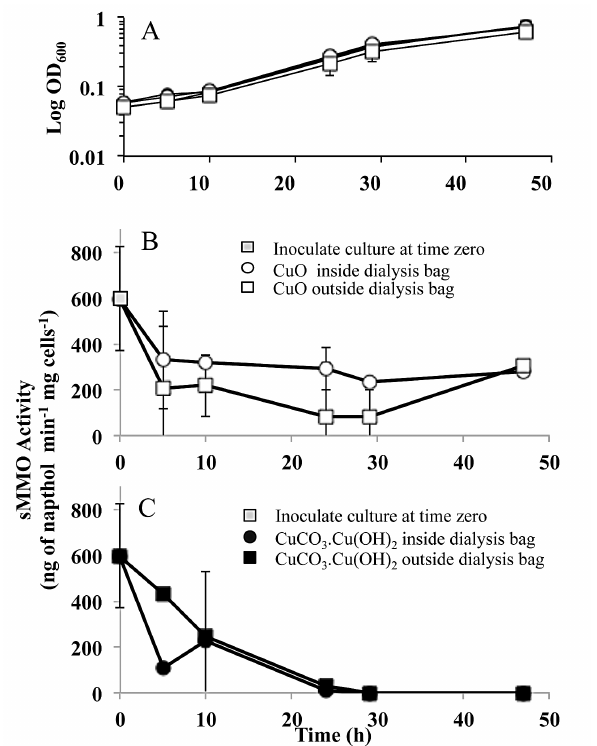
Fig. 2. Affect of direct mineral contact on the maintenance of sMMO activity (ng of naptholmin − 1 mgcelldryweight − 1 ) when the initial culture has sMMO activity. (A) Growth curves for CuO and CuCO 3 .Cu(OH) 2 at 50µmoltotal-Cul − 1 where the mineral was inside and outside of < 1000Da sieve size dialysis bags in the culture flask ( n = 2 per treatment). (B) sMMO activity over time as function of location of CuO; i.e. inside and outside of the dial- ysis bags. (C) sMMO activity over time as function of location of CuCO 3 .Cu(OH) 2 ; i.e. inside and outside of the dialysis bags. Error bars represent standard deviations ( n = 3).